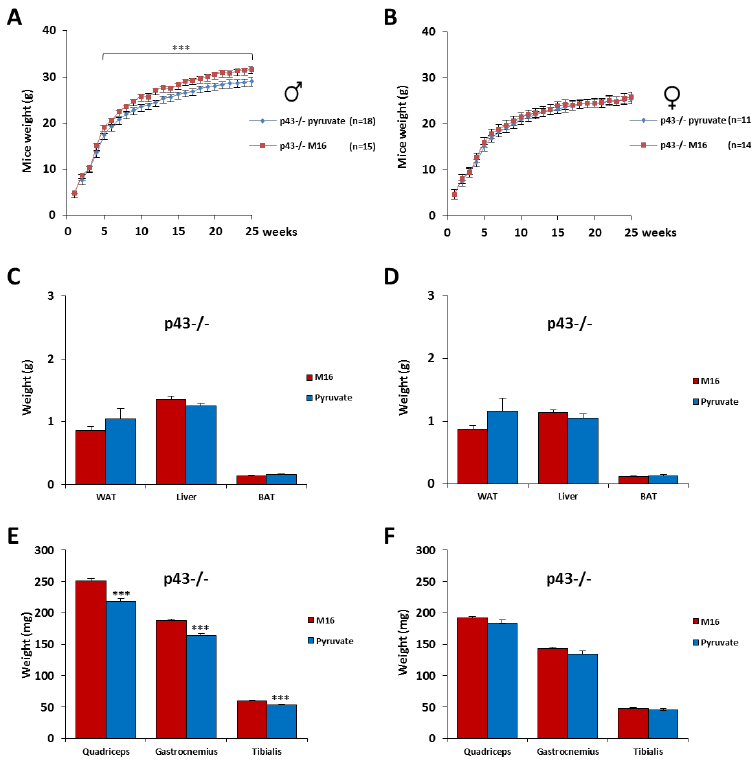
Figure 4. Skeletal muscle hypertrophy was fully abrogated for p43−/− male mice by a short exposure in M16 / pyruvate medium at the 1 cell embryo stage. Post-natal growth profiles of male ( A ) and female ( B ) p43 − / − mice derived from zygotes incubated in M16 or M16 / pyruvate media. At 6 months of age, the mice were sacrificed and WAT, BAT, and liver were weighed ( C : male; D : female), as well as the skeletal muscles (quadriceps, gastrocnemius, and tibialis) ( E : male; F : female). For male p43 − / − mice, n = 18 in M16 medium and 15 in M16 / pyruvate medium. For female p43 − / − mice, n = 11 in M16 medium and 14 in M16 / pyruvate medium. Statistical significance: *** p < 0.001, Student’s t -test. Results are expressed as ±